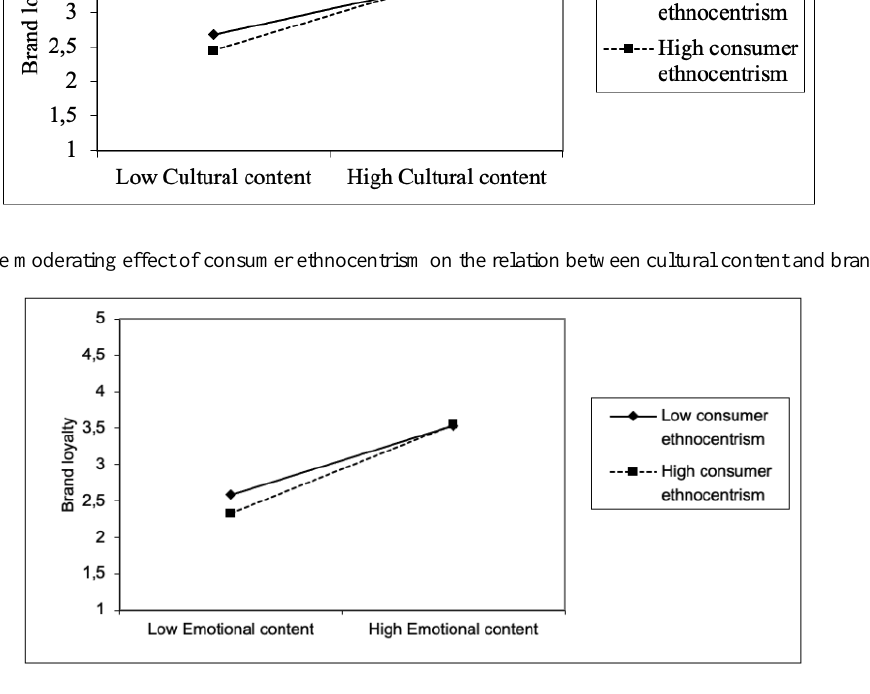
Figure 9 : The moderating effect of consumer ethnocentrism on the relation between emotional content and brand